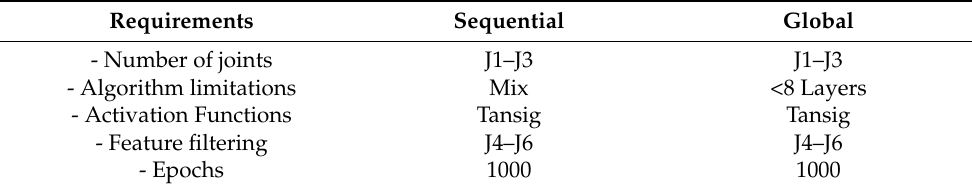
Table 8. GA/ANN optimization inputs for the FANUC LR Mate